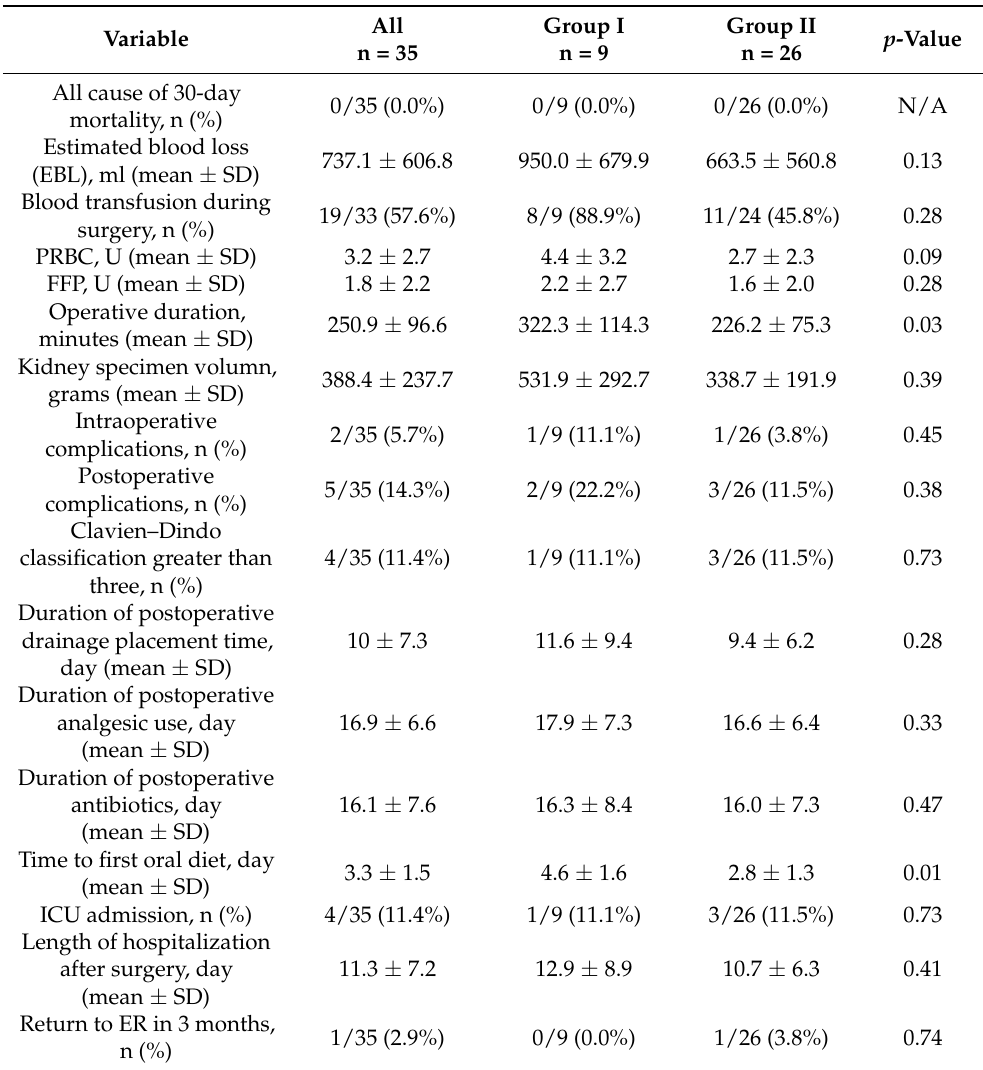
Table 2. Perioperative and postoperative results.